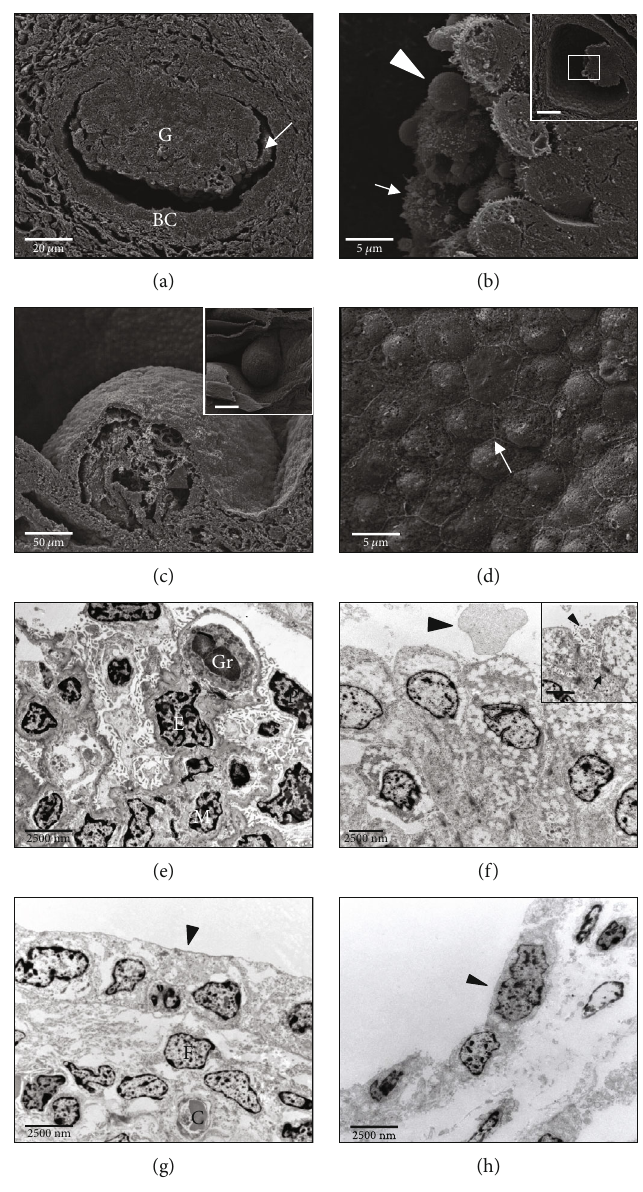
Figure 4: Ultrastructural fi ndings of the renal tissue (SEM, TEM). Nephrons (a, e): (a) matured nephrons show normal structured glomerulum with capillary loops (arrow) and Bowman ’ s capsule (BC). (e) Correspondingly, TEM reveals granulocytes (Gr) within glomerular capillaries, surrounded by podocytes (P), mensangial cells (M), and endothelial cells (E). Epithelial proliferates/projections (b, f): (b) proliferates show several apical di ff erentiations comprising microplicae/micro fi laments (arrow) and supracellular granular constrictions (arrowhead). (f) Microplicae and granules are also obvious in TEM sections (arrowheads). Cell somata show numerous di ff usely distributed round, demarked cytoplasmic structures and few organelles. Intercellular areas are characterized by several desmosomes (inset, arrows). Protrusions (c, g): (c) SEM shows a cobblestone-like, slightly convex cellular relief. (g) Epithelial surfaces of the protrusions show a predominantly cuboidal epithelium without visible apical structures (arrowhead). The underlying fi brovascular tissue is characterized by several fi broblasts (F) and capillaries (C). Cyst (d, h): (d) cyst wall epithelium appears similar to epithelial linings of the protrusions and mainly consists of a fl attened and slightly convex epithelium. There are numerous intercellular formations of microplicae (arrow). (h) The epithelium predominantly appears fl at and without any visible apical structures